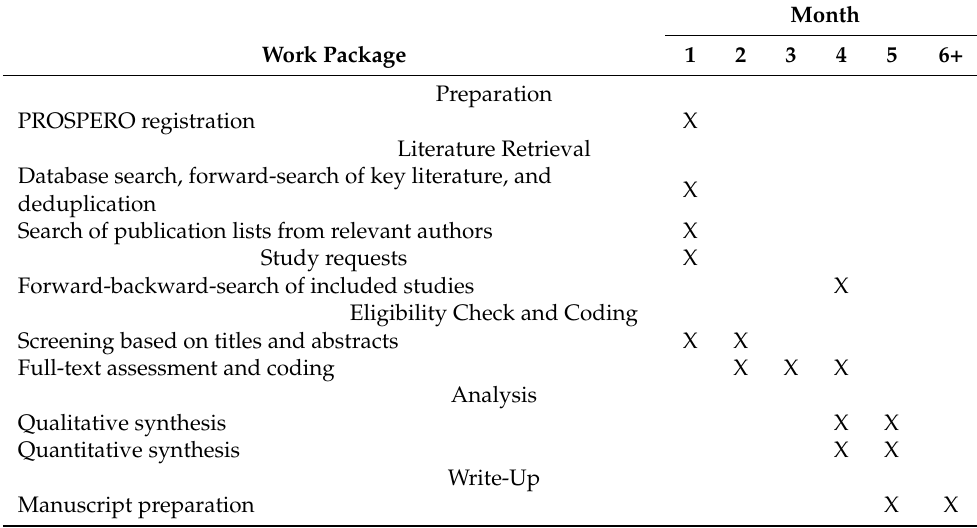
Table 3. Timeline for the systematic